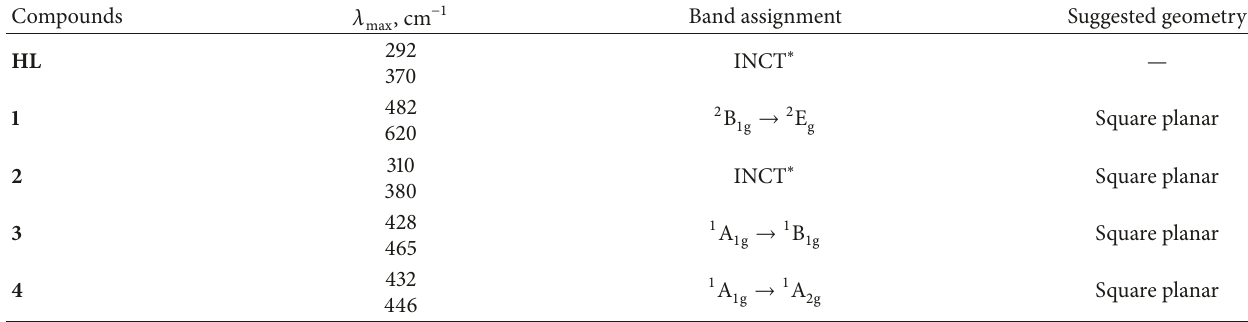
Table 4: Electronic spectral data of the synthesized